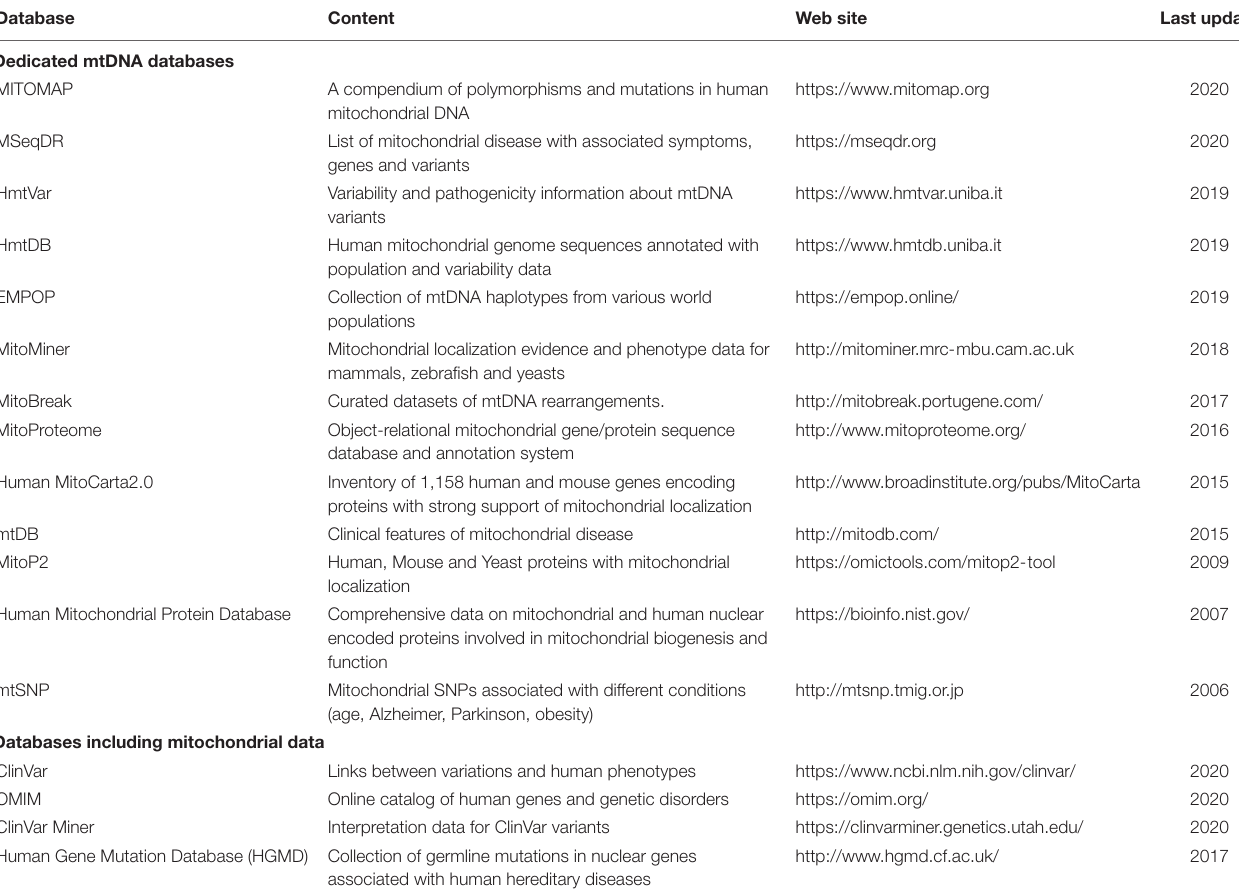
Table listing the databases containing information on mitochondria and mitochondrial diseases, links to web site databases and the year of their last update.